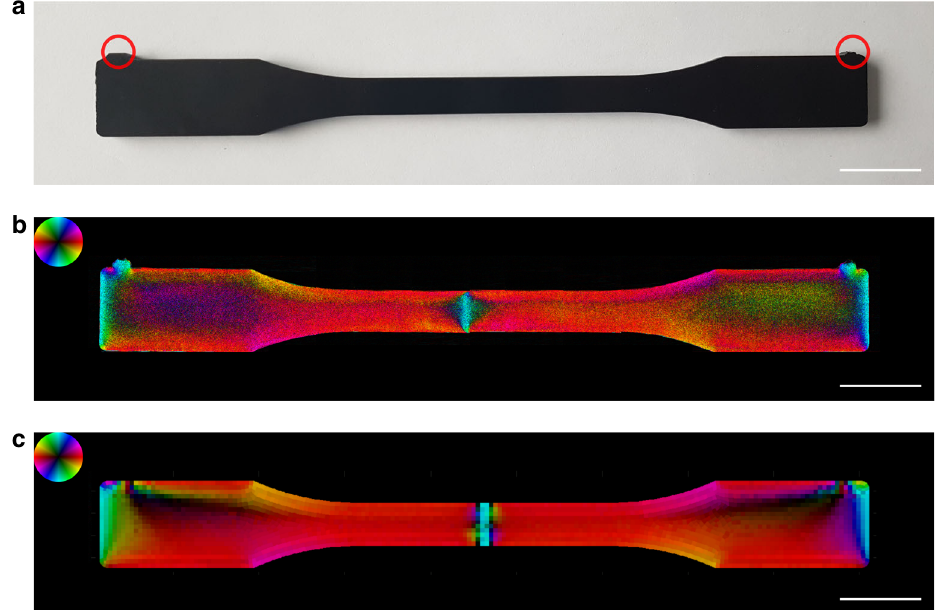
Fig. 2 Imaging of fi bre orientation in reinforced polymers. The glass fi bre reinforced tensile sample ( a ) was injection moulded from the two inlets marked by the red circles creating a weld line near its centre. The extracted fi bre orientation map ( b ) was compared with the fi nite element fl ow simulation shown in ( c ). In general a high agreement between the simulation and the measurement is observed. However, the simulation fails to predict the exact location and shape of the weld line which is a highly critical area. The scale bars correspond to 2